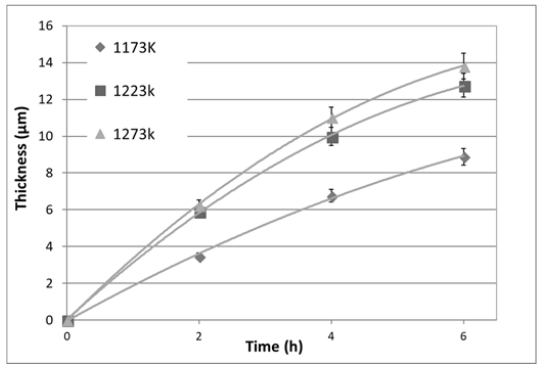
Figure 2. NbC coating thickness vs. time TRD at various treatment temperatures.